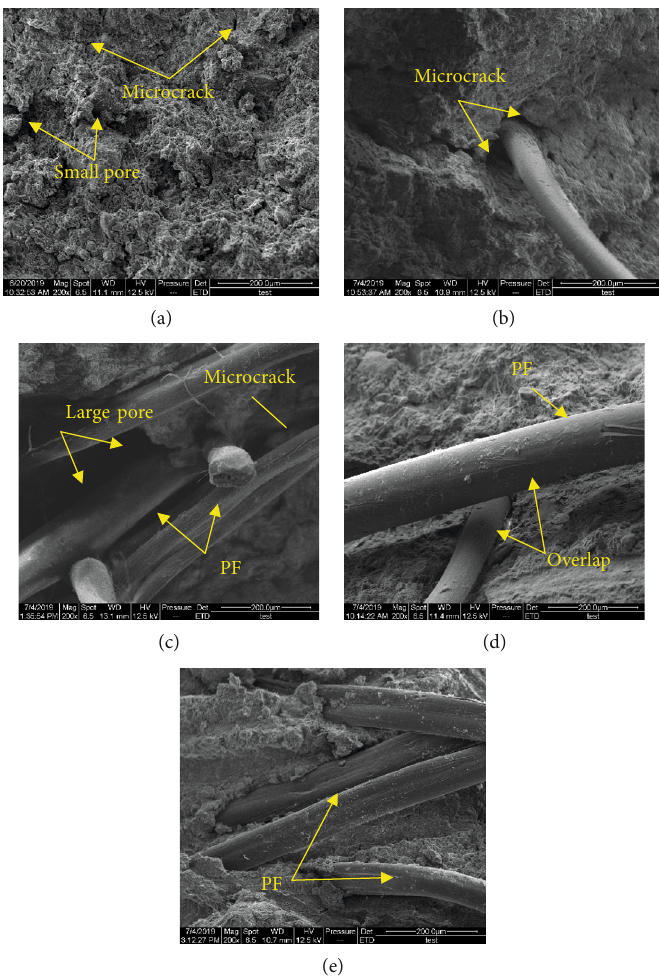
Figure 11: SEM images of (a) untreated soil, (b) soil with 0.75% PF, (c) soil with 1.5% PF, (d) soil with 2.25% PF, and (e) soil with 3%